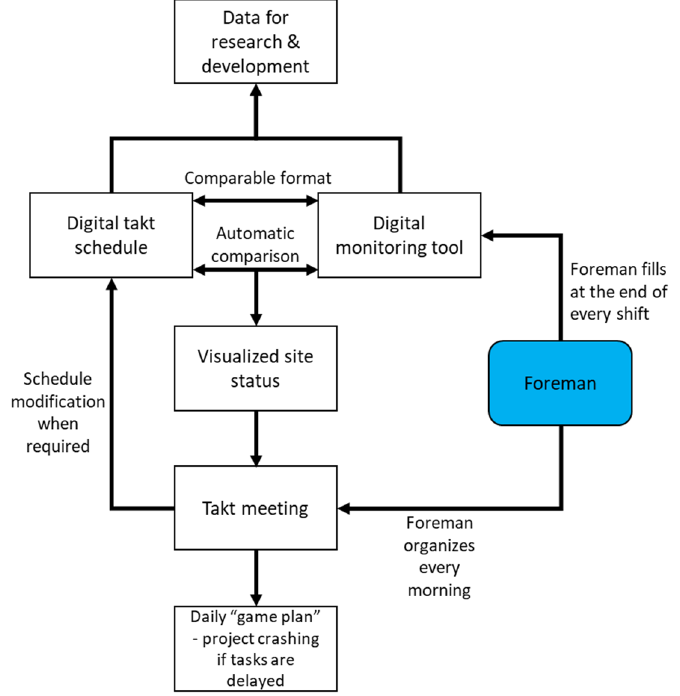
Figure 10. The takt production monitoring and control flow chart drafted based on observations in the case site of this study.